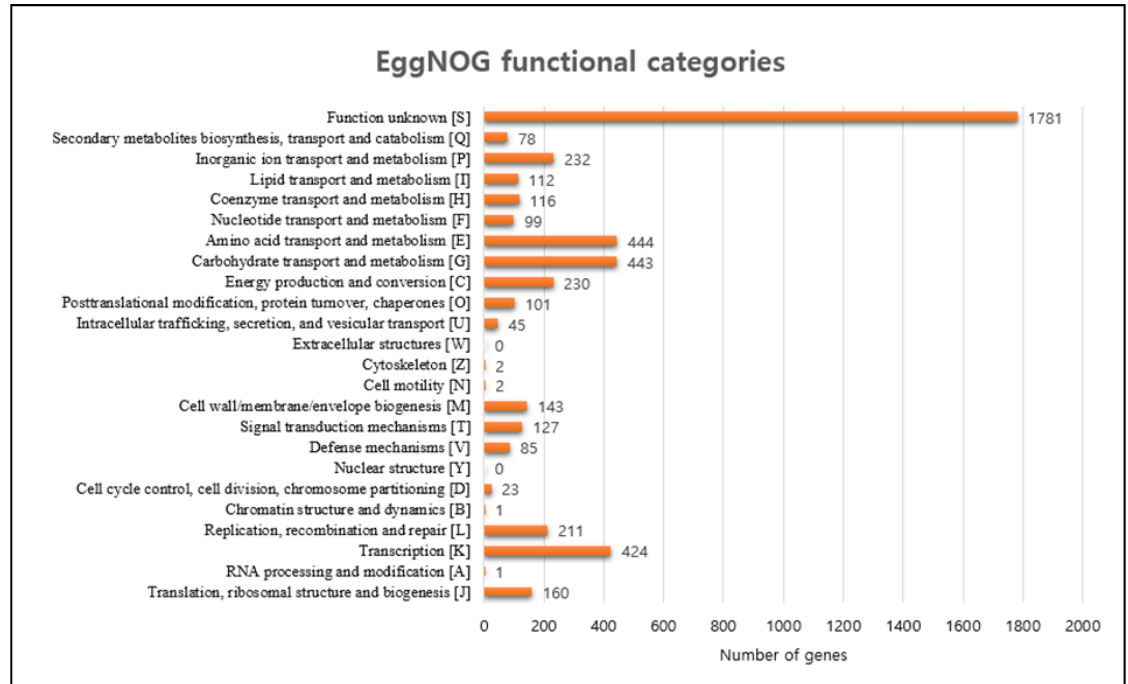
Figure 7. Functional classification of proteins in the genome of strain GN70 by eggNOG annotation.